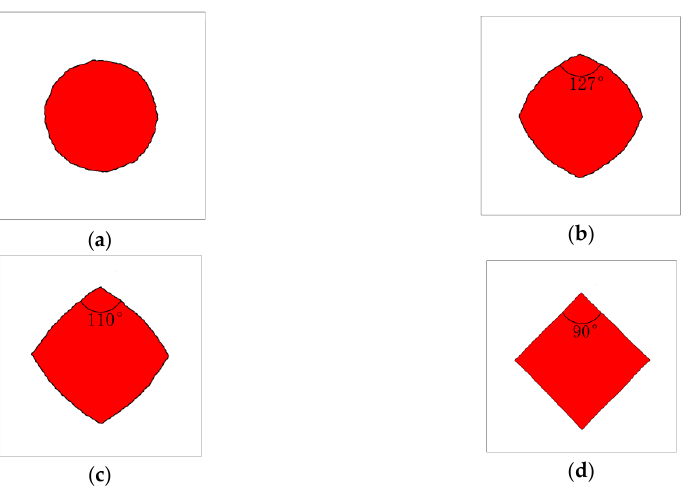
 : ( a ) Figure 6. Simulation results for different values of λ :( a ) λ = 0 ; ( b ) λ = 1 ; ( c ) λ = 4 ; ( d ) λ = 10 ; δ = 4 .